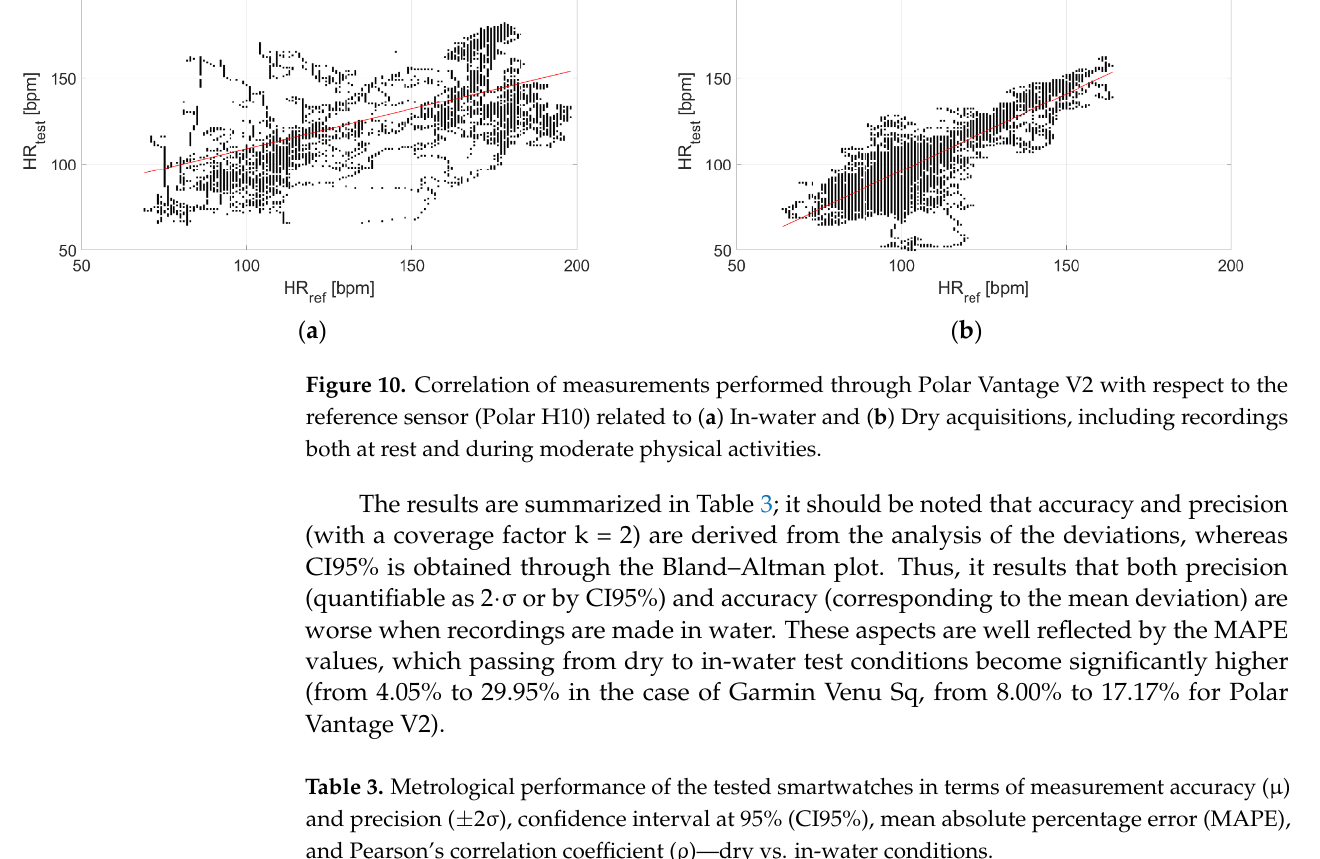
Figure 9. Correlation of measurements performed through Garmin Venu Sq with respect to the ref- erence sensor (Polar H10) related to ( a ) In-water and ( b ) Dry acquisitions, including recordings both at rest and during moderate physical activities.